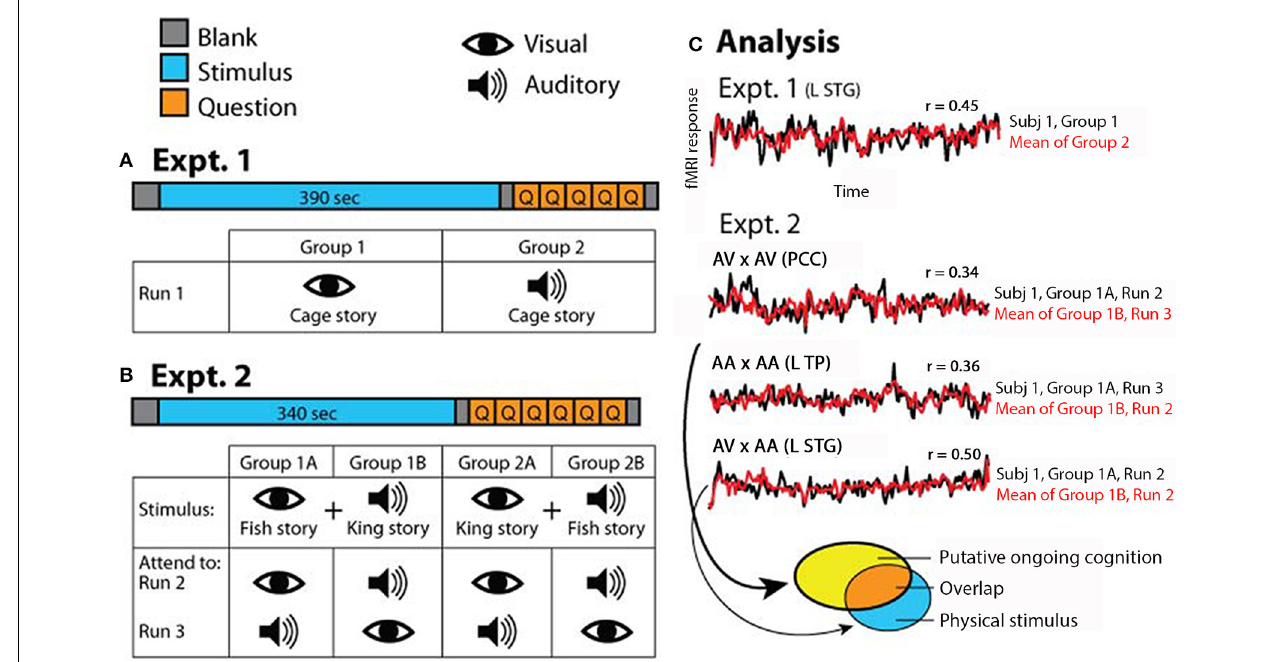
FIGURE 1 | Experimental paradigm. (A) In Experiment 1, which consisted of one fMRI run, half of the subjects read the “Cage” story and the other half listened to the “Cage” story. (B) In Experiment 2, which consisted of two runs, half of the subjects were exposed to simultaneous auditory recording of “King” story and visual text presentation of “Fish” story (Group 1), and the other half exposed to simultaneous auditory recording of “Fish” story and visual text presentation of “King” story (Group 2). Subjects were instructed to attend to a specific sensory stream in one fMRI run and the other stream in the second run; the order of attended modality was counterbalanced within each group. (C) Schematic of analysis approach. In Experiment 1, correlations were computed between the two groups of subjects for each